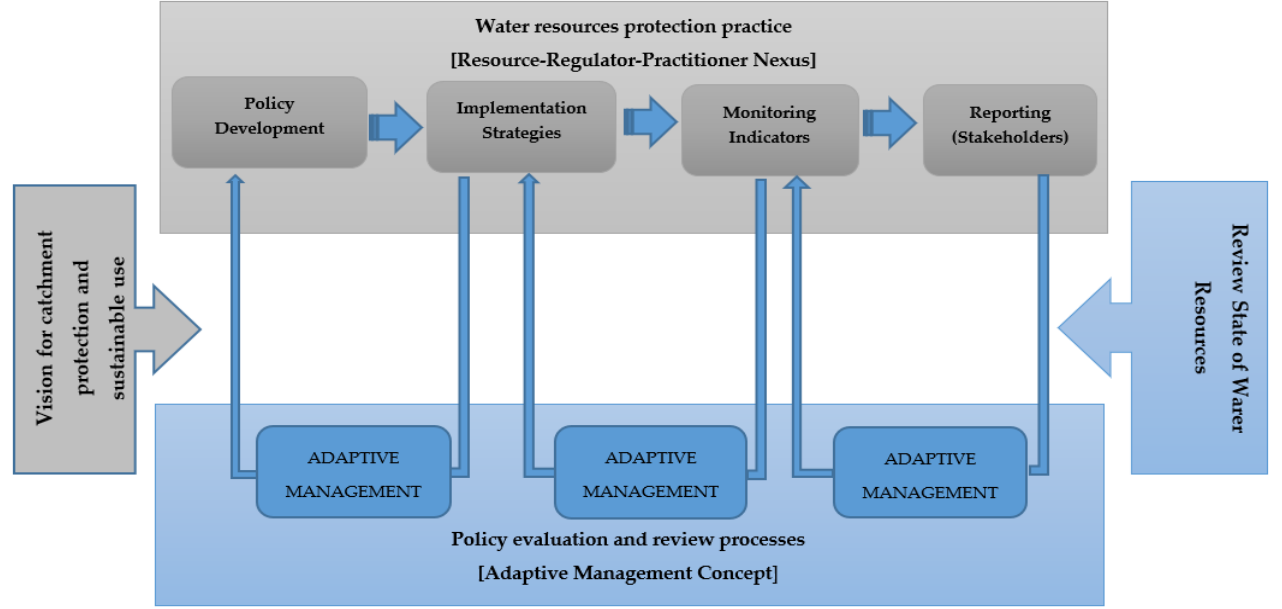
Figure 2. Conceptual framework for water resources protection using results-oriented monitoring .